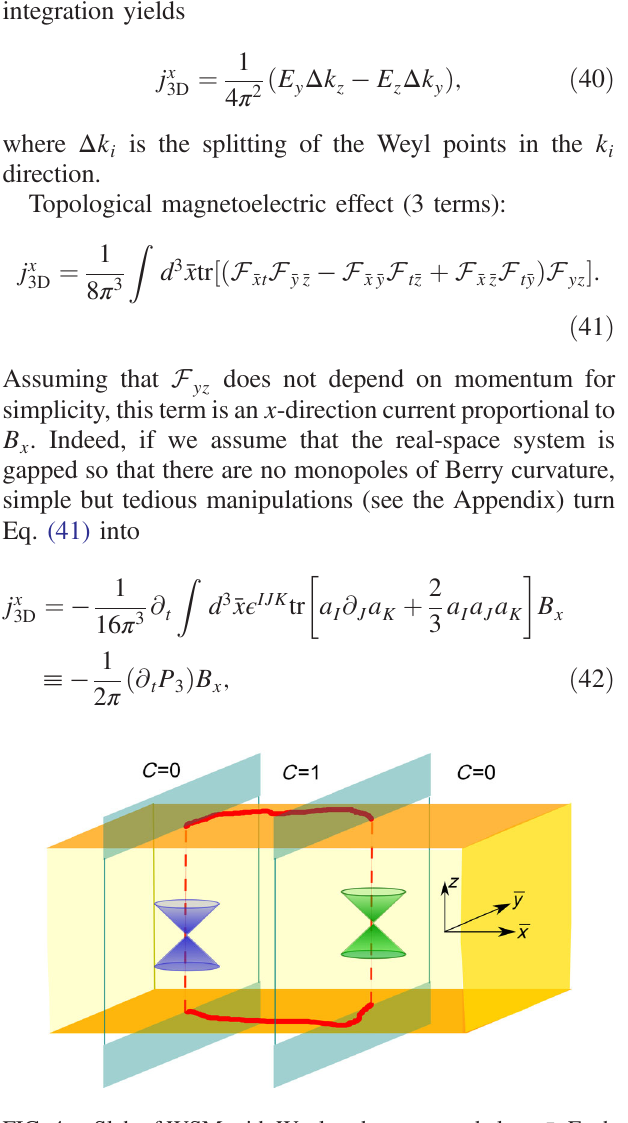
FIG. 4. Slab of WSM with Weyl nodes separated along ¯ x . Each slice in momentum space with fixed ¯ x can be characterized by a Chern number C 1 ð ¯ x Þ , which changes by unity across the Weyl nodes. Thus, the region between the nodes in the above figure is a series of Chern insulators. The edge states of these Chern insulators constitute the Fermi arcs, marked as thick red lines with an irregular shape. Note that the cones are only present as a cartoon to depict the position of the Weyl nodes; the vertical direction in the figure is z and should not be confused with energy. The figure is adapted from Ref.